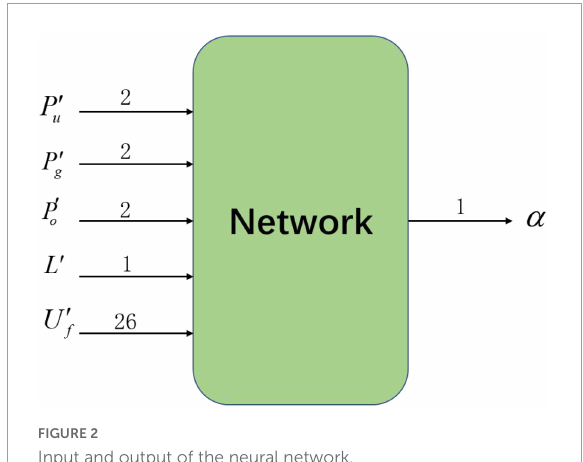
FIGURE2 Input and output of the neural